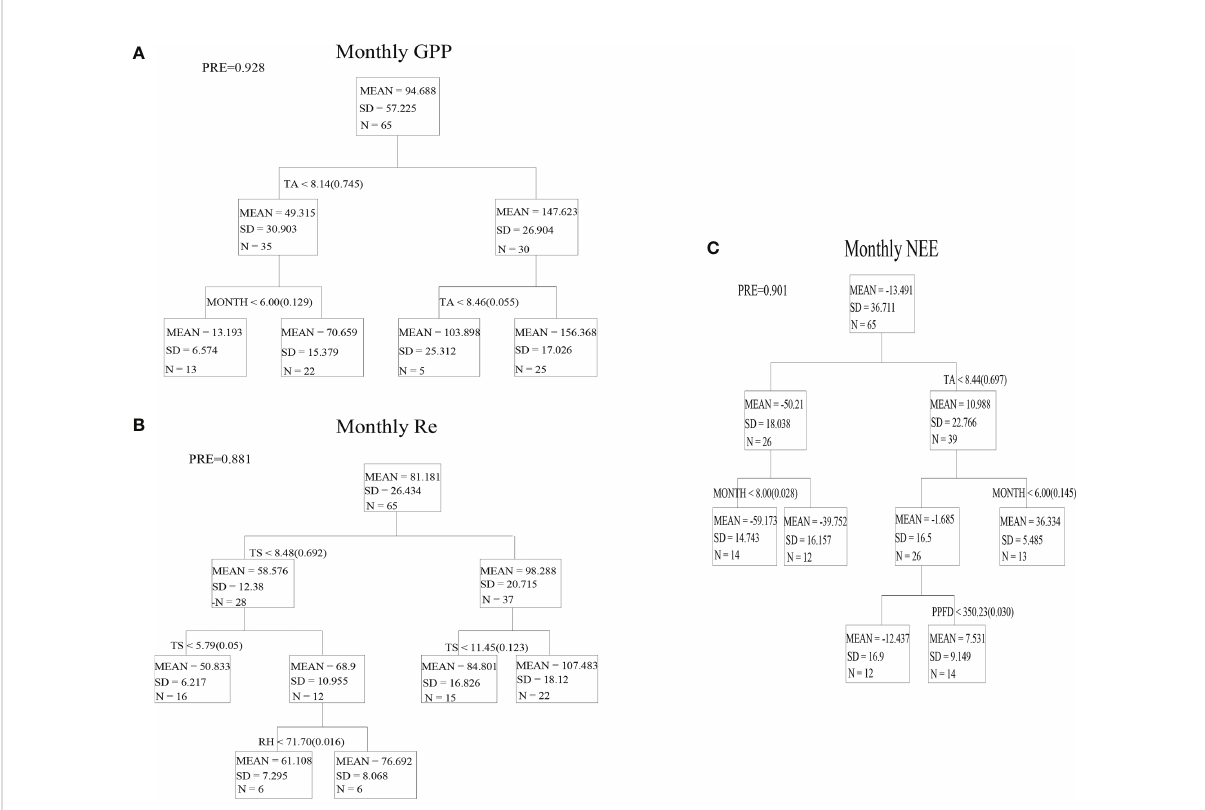
FIGURE 5 Regression trees for monthly GPP (A) , Re (B) and NEE (C) from environmental variables of alpine wetland in the growing season (May- September).